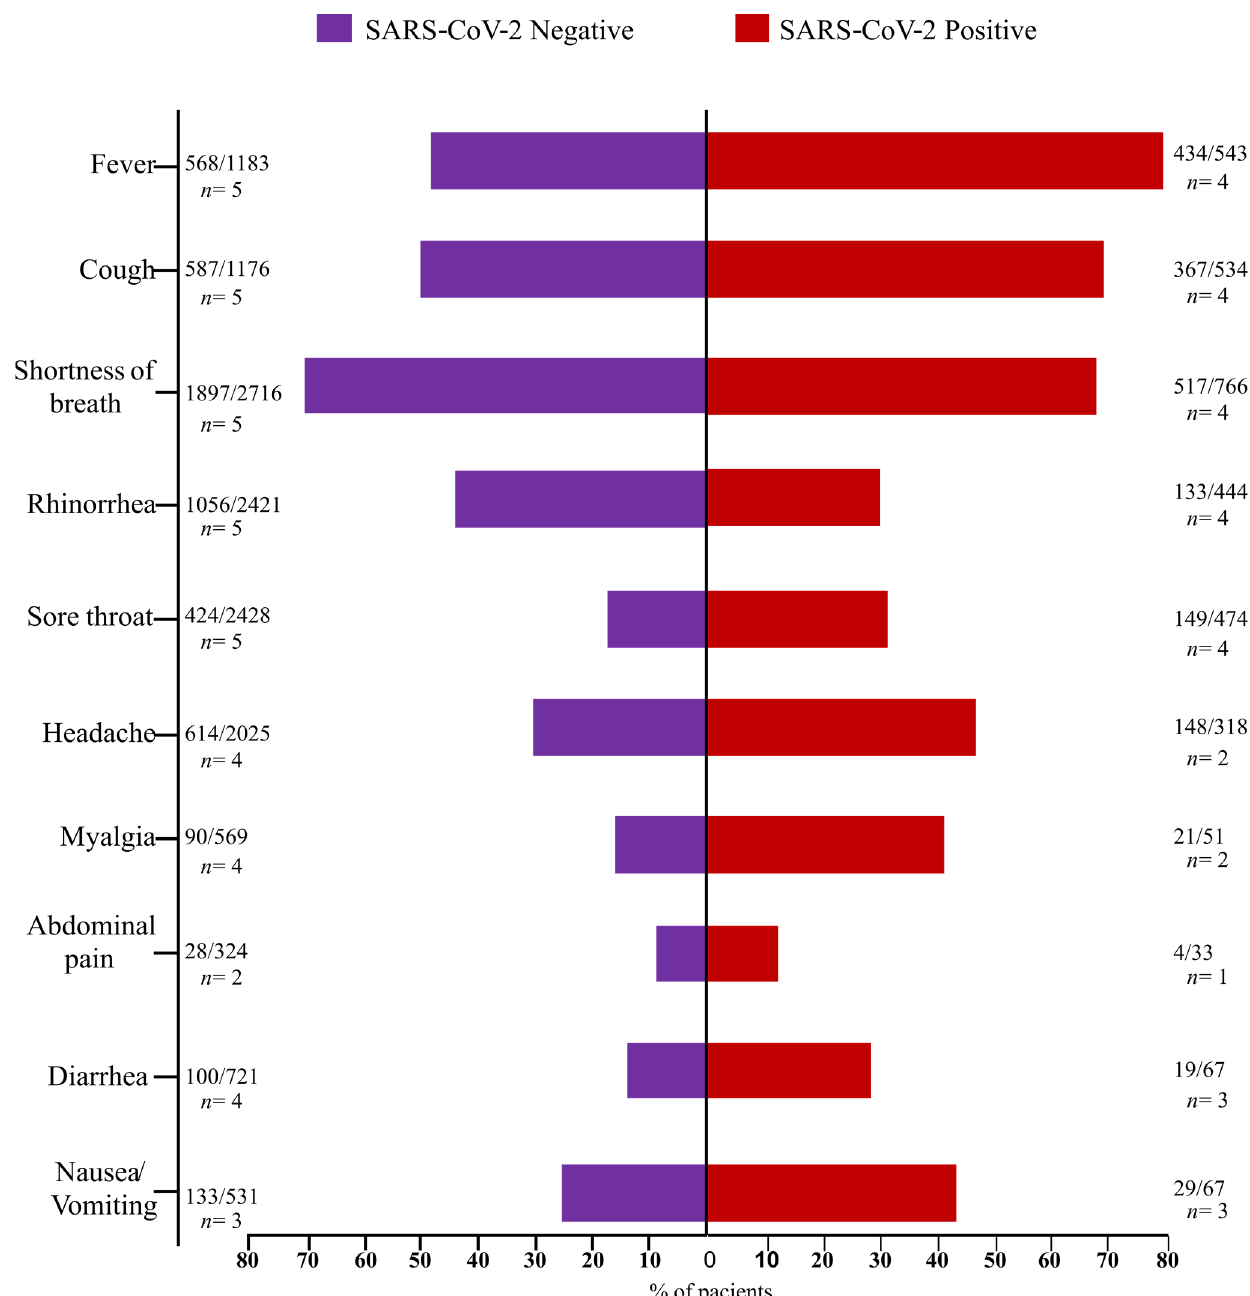
Figure 1. Clinical features among SCNG versus SCPG patients [46,47,51,54,59].